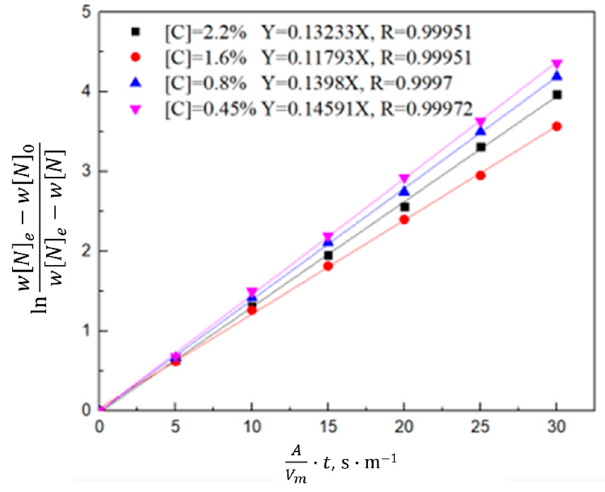
Figure 8. Kinetics of the nitrogen amount in the molten steel with different carbon contents.